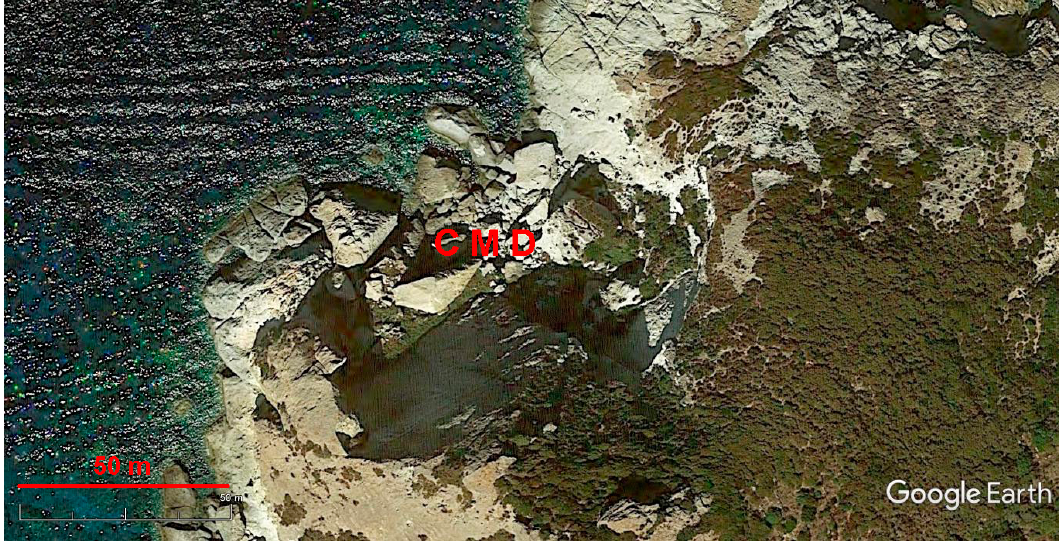
Figure 5. The northwestern plot of the Ponza Island locality (the view provided by the Google Earth Engine).